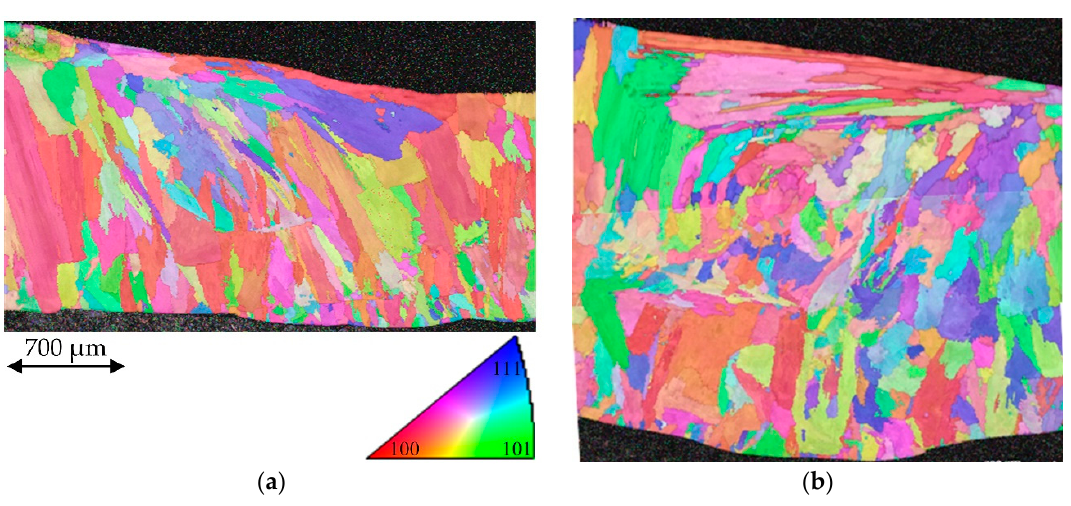
Figure 10. Inverse pole figures (IPF) of clad I and II—( a , b ), respectively—showing columnar grains that are inclined to the transition zone of substrate/clad (TZ-S/C) and extensive heterogeneous nucleation close to the TZ-S/C. IPF coloring is parallel to the axis pipe.